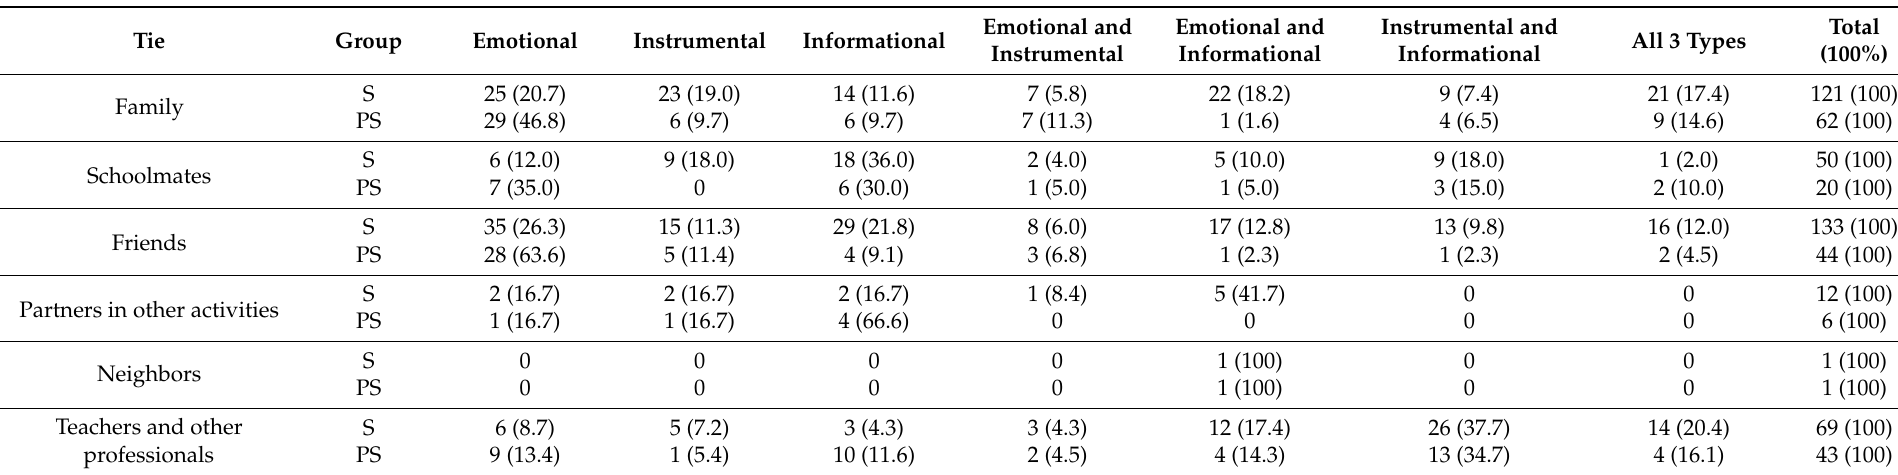
Table 6. Type of support received by tie for each